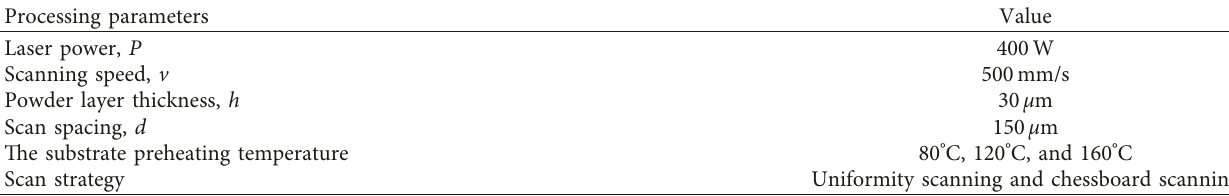
Table 2: SLM processing conditions.